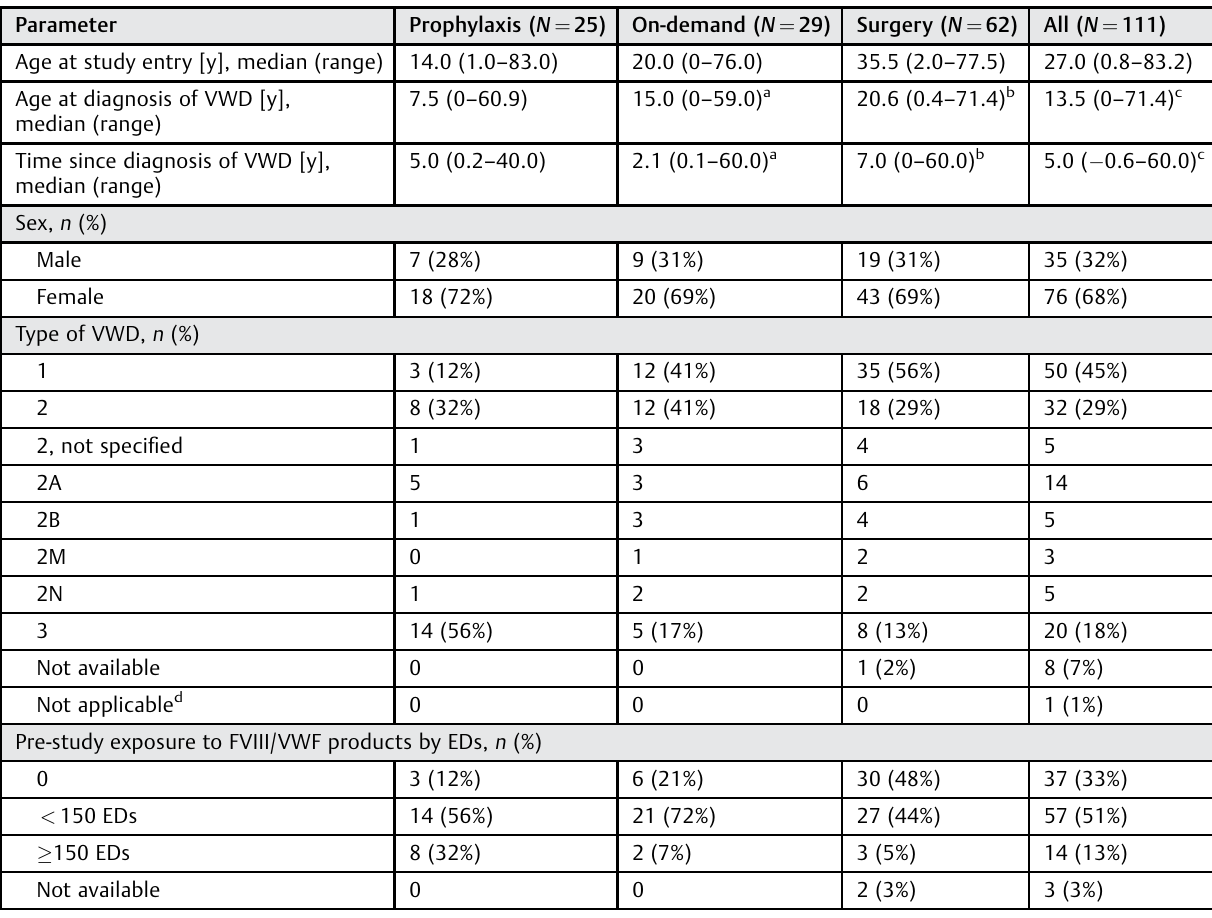
Table 1 Baseline demographic and clinical